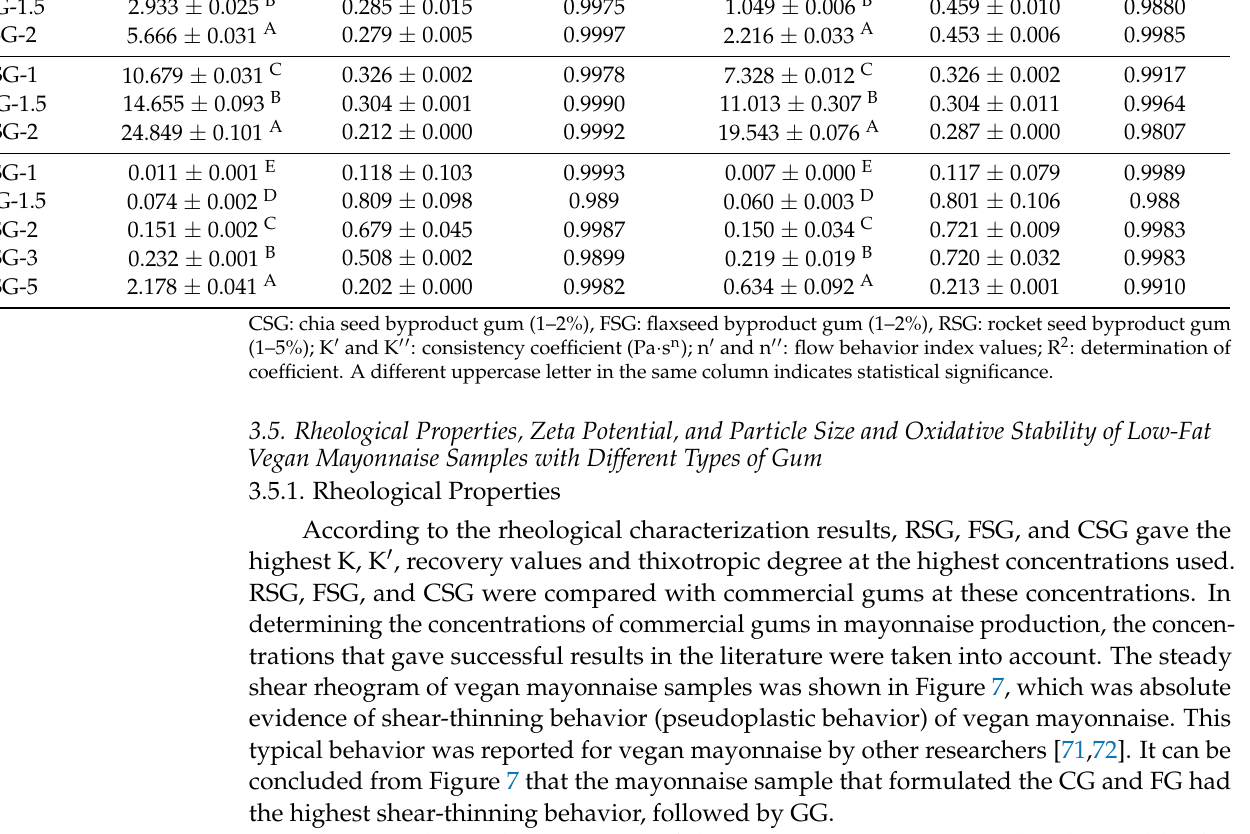
Figure 7 indicated the 3-ITT rheological properties of the vegan mayonnaise